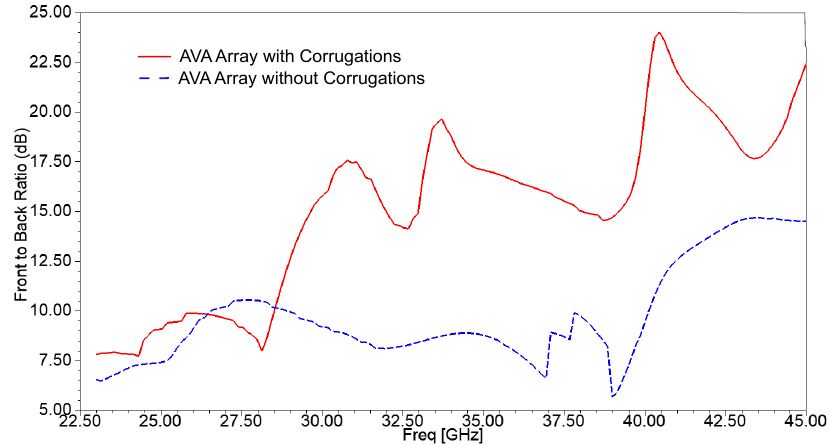
Figure 15. Simulated front-to-back ratio of the AVA array with and without corrugations.